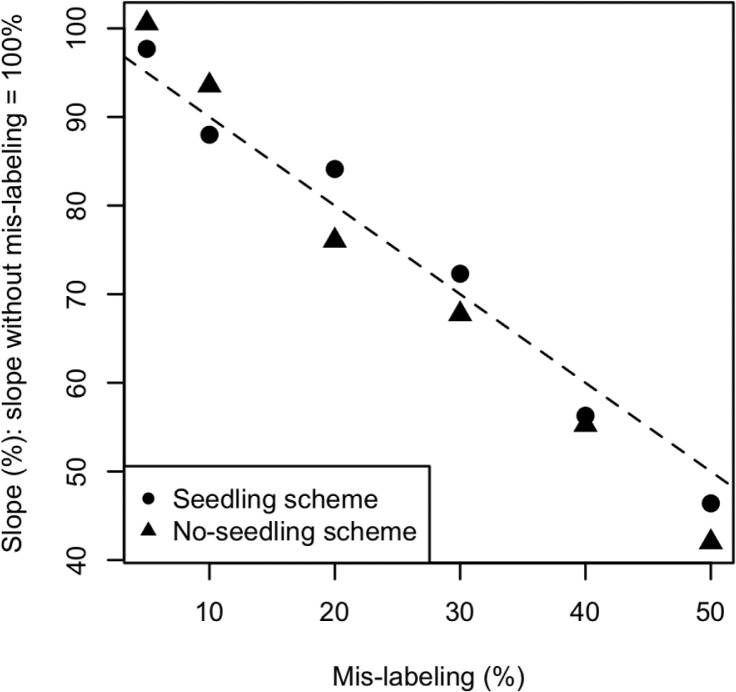
Observed response to selection from Cycle 2 to Cycle 4 with source errors. The vertical axis represents genetic gain as a percentage of the gain observed without mislabeling. The dashed line has a slope of −1 and an intercept of 100%.